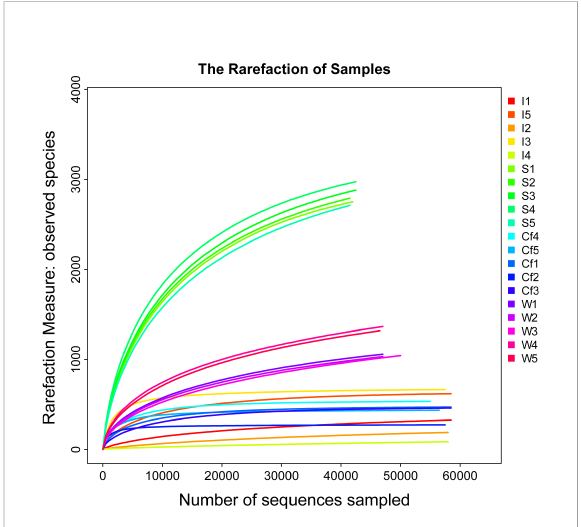
FIGURE 1 The rarefaction curves and rank abundance curve of different